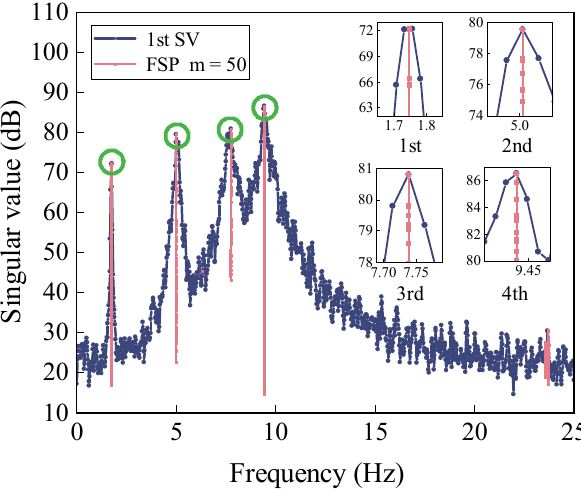
Figure 6. First-order singular value plots obtained from FSP-FDD.